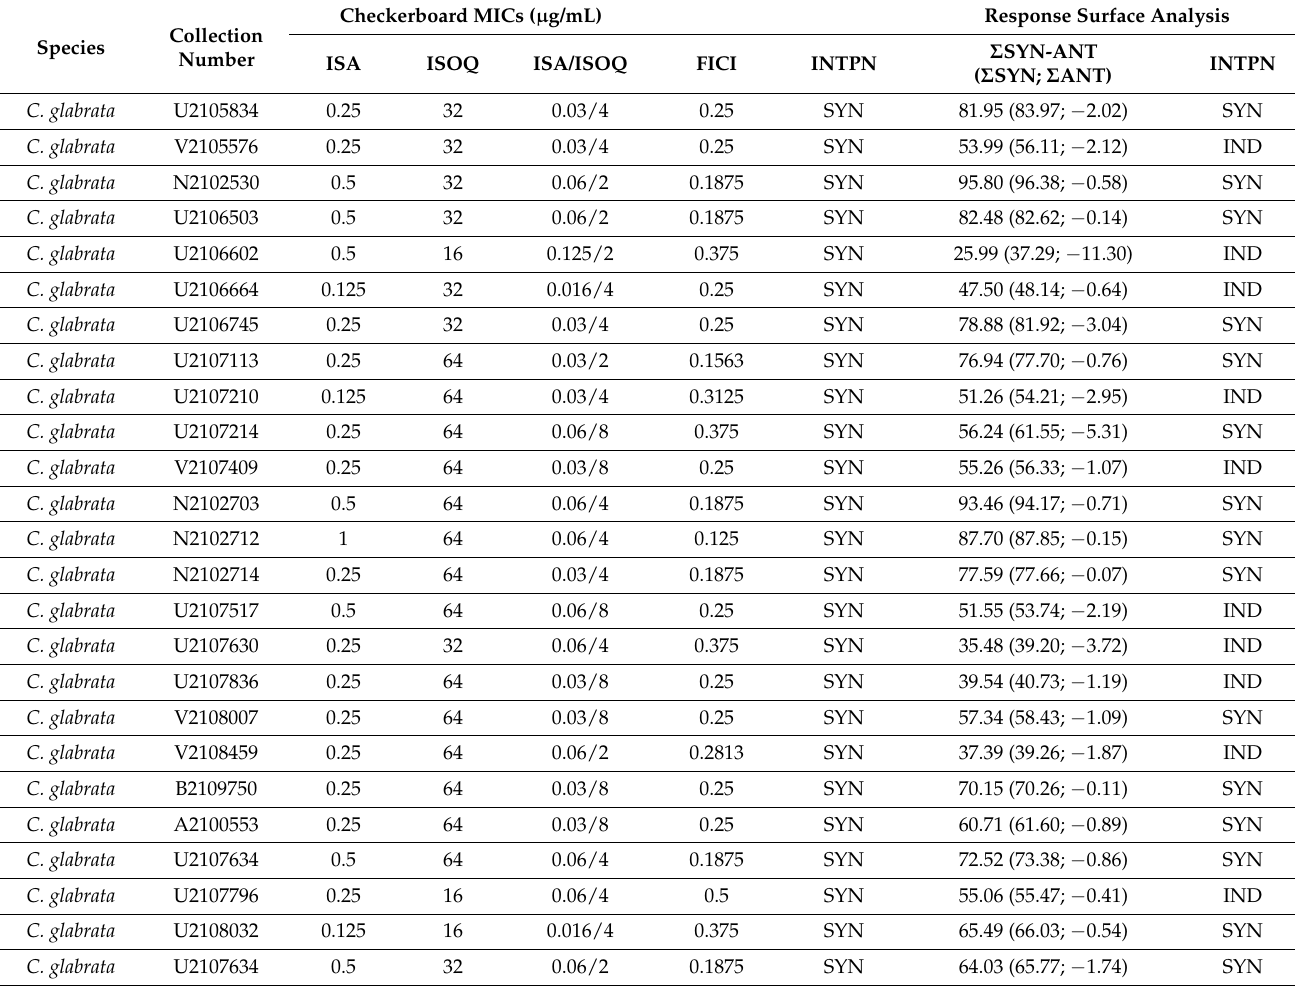
Table 2. Interaction of isavuconazole with isoquercitrin against C. glabrata evaluated by checkerboard and interpretation by fractional inhibitory concentration index and response surface analysis.